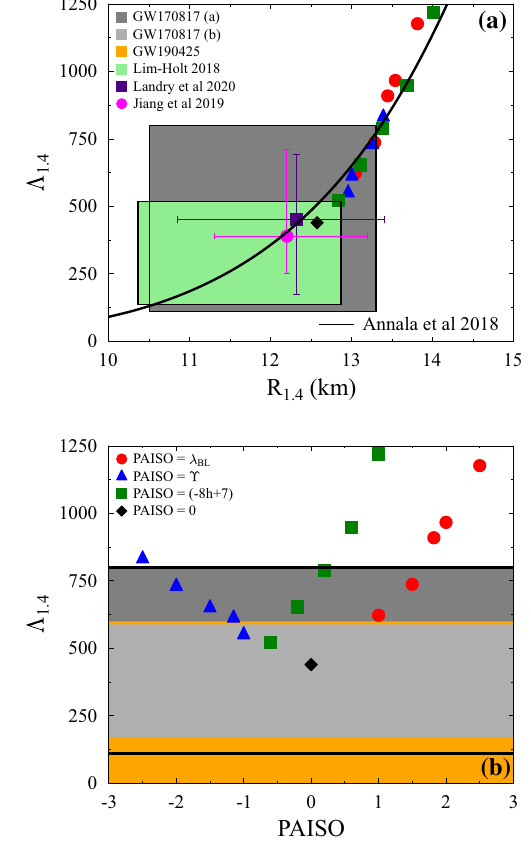
Fig. 12 Impact of anisotropic pressure for all anisotropic pressure models on dimensionless tidal deformability for M = 1.4 M (cid:3) . a (cid:3) 1 . 4 as a function of radius and b as a function anisotropic pressure parameters. For comparison, we also include the new non-parametric constraint on dimensionless tidal deformability from Ref. [9] and the constraint from joint of PSR J0030+0451, GW170817, and the nuclear data analysis constraints from Ref. [30], Constraints on EOS from experiments and chiral effective theory using Bayesian framework [31], empirical for- mula from Ref. [32] as well as the results from GW170817 ( a ) [14,16], GW170817 ( b ) [15] and GW190425